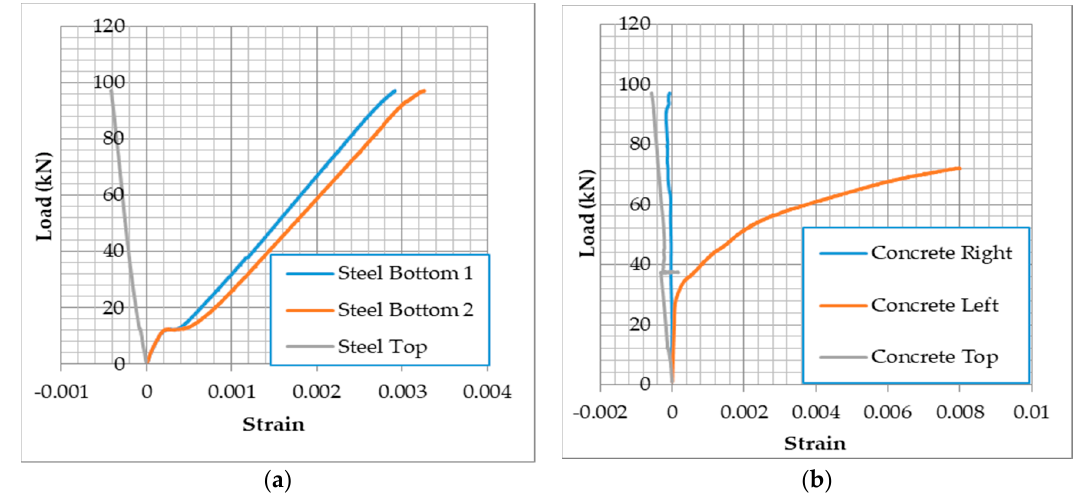
Figure 16. Strain in steel and concrete—RCA-SY-1, ( a ) Strain in bottom and top steel bars, ( b ) Strain in concrete.